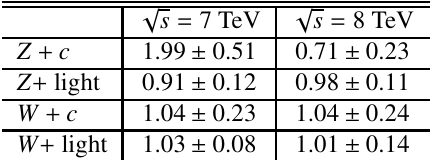
Table 3. Rescaling factors obtained from a fit to the data for the V + light and c -jet backgrounds [9]. The error includes statistical and systematic uncertainties.